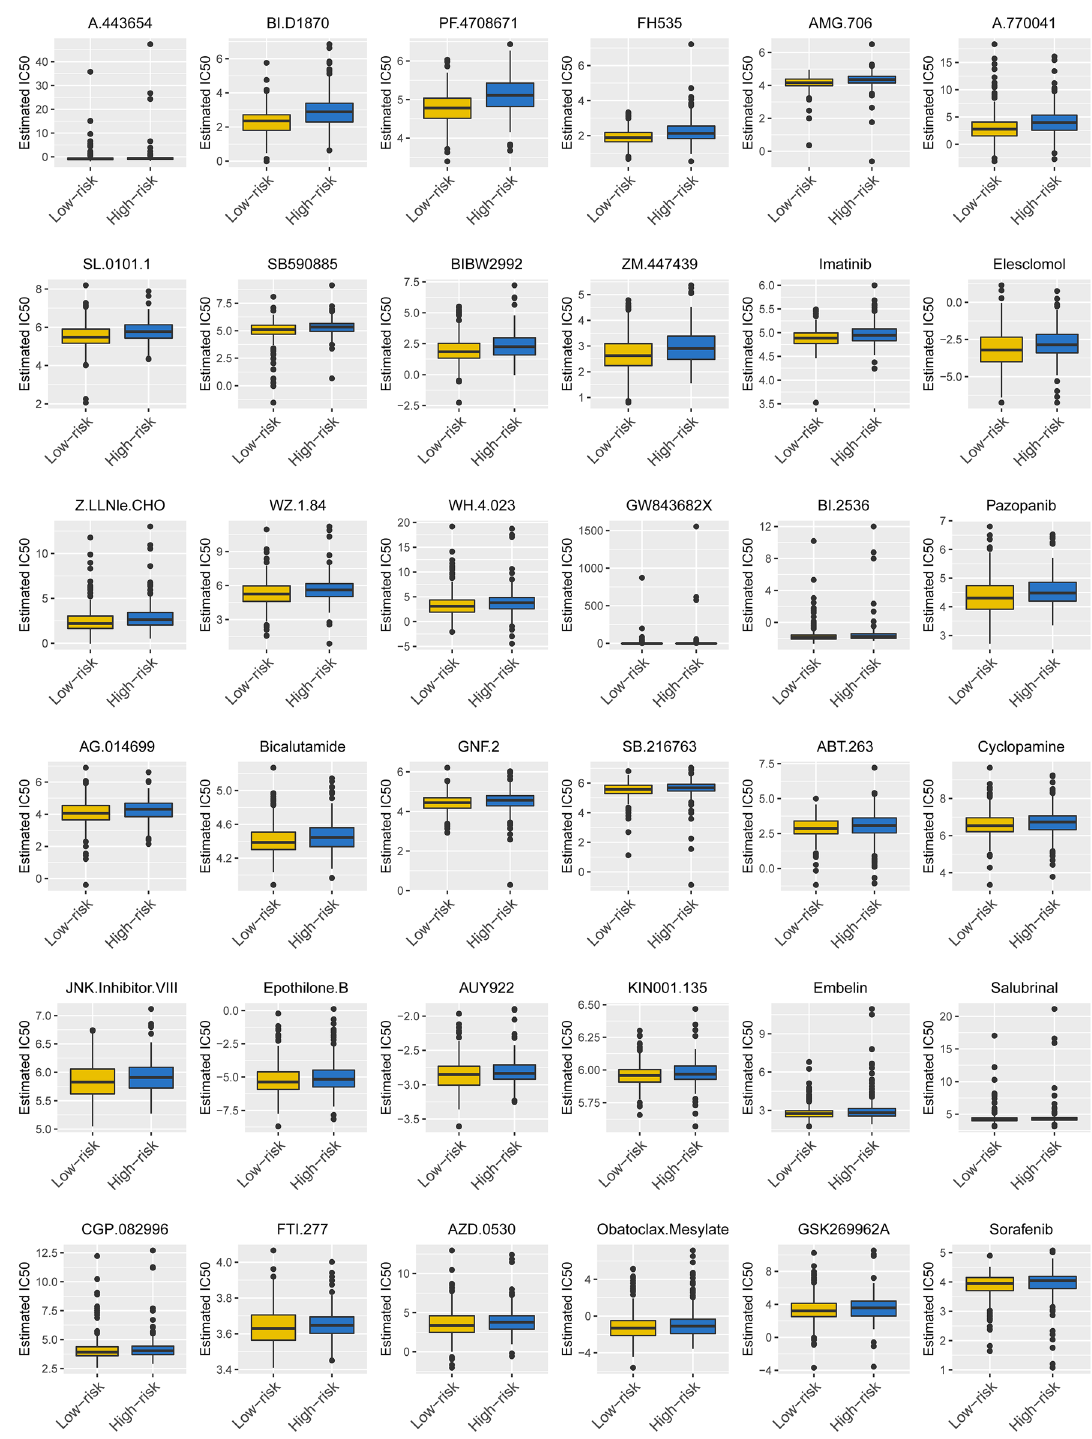
Figure 10. Different chemotherapeutic responses in high- and low-risk patients with LUAD ( P < 0.05). sup_ figure: Study flow